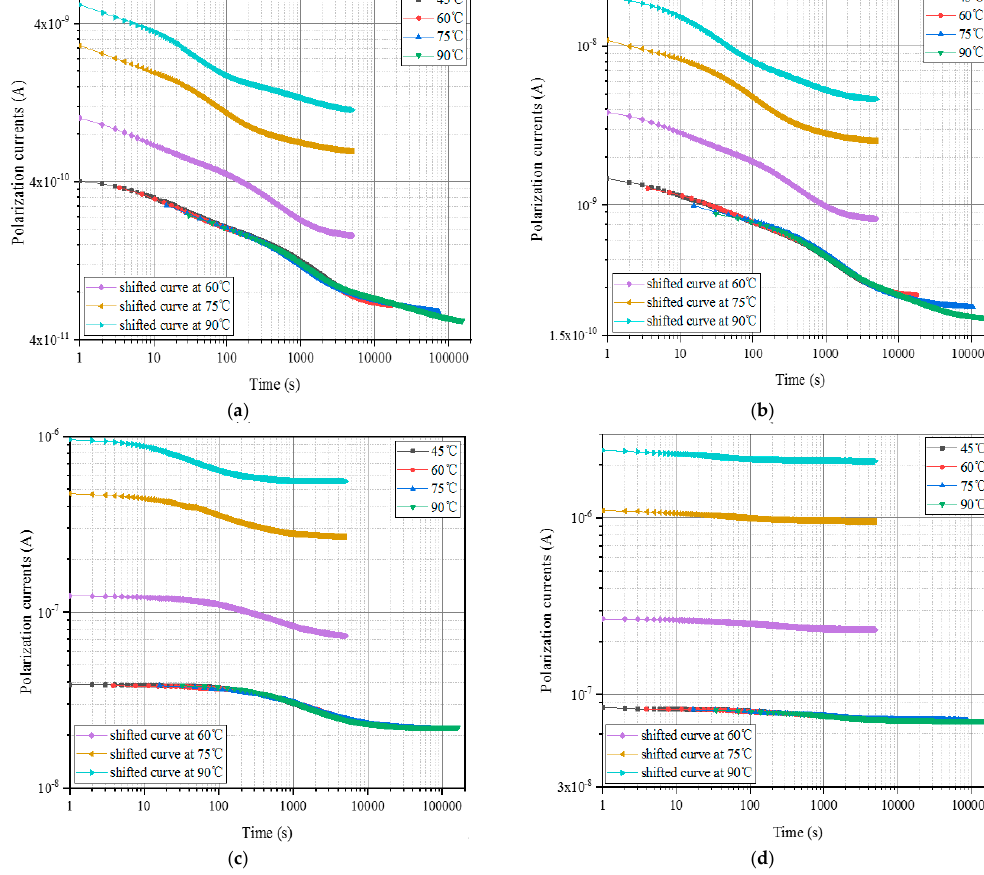
Figure 3. The construction results of the master curve of unaged polymer pressboards with various moisture contents at different test temperatures. ( a ) mc % = 0.81%, ( b ) mc % = 1.56%, ( c ) mc % = 2.62%, ( d ) mc% = 3.84%.